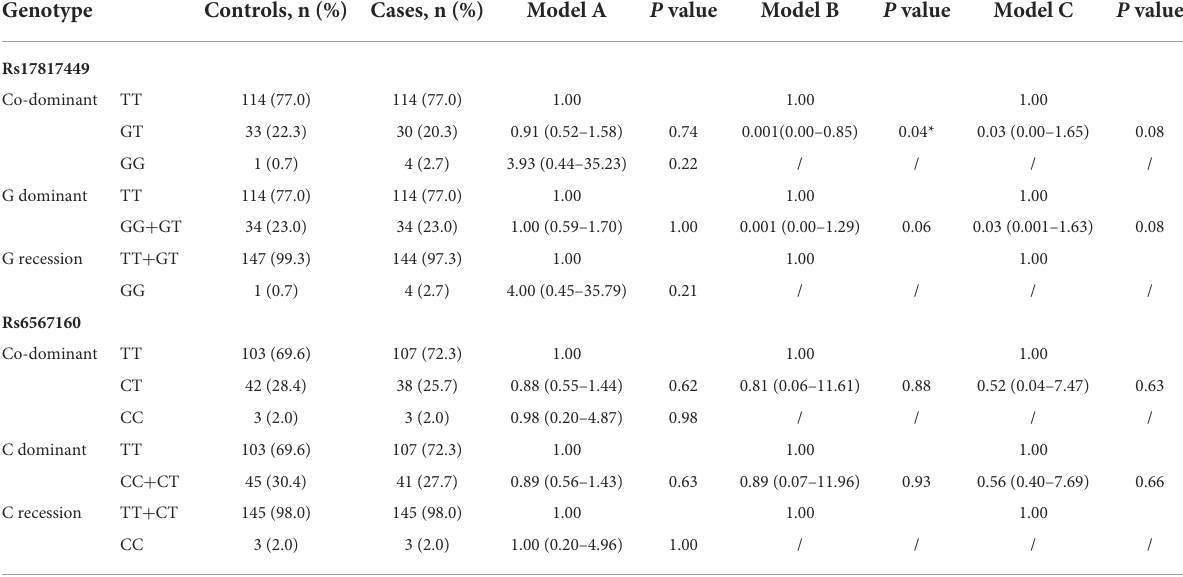
TABLE 4 Genotype distributions and associations between rs17817449 and rs6567160 with the risk of all strokes ( n = 296).